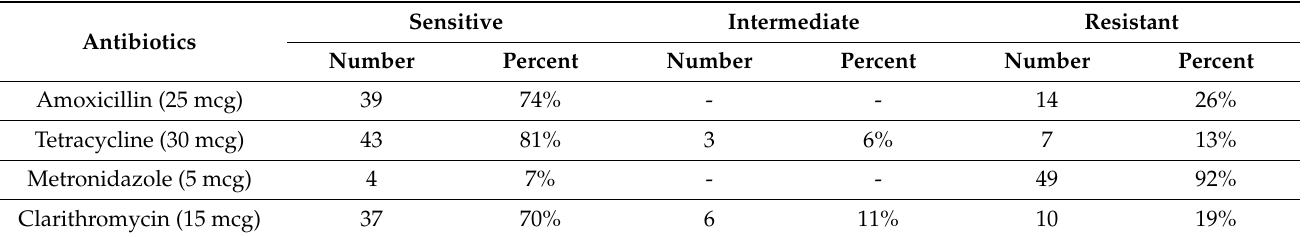
Table 7. Antibiotic sensitivity for H. pylori